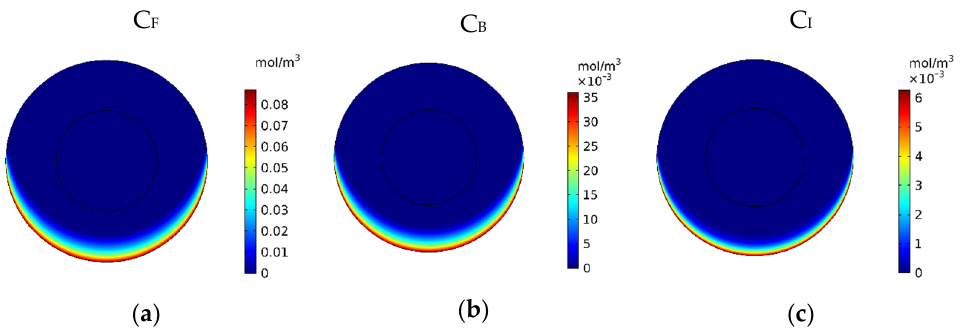
Figure 10. Contours of the ( a ) free, ( b ) bound and ( c ) internalized drug concentrations 60 min after the start of treatment with a magnetically controlled IP drug targeting system.